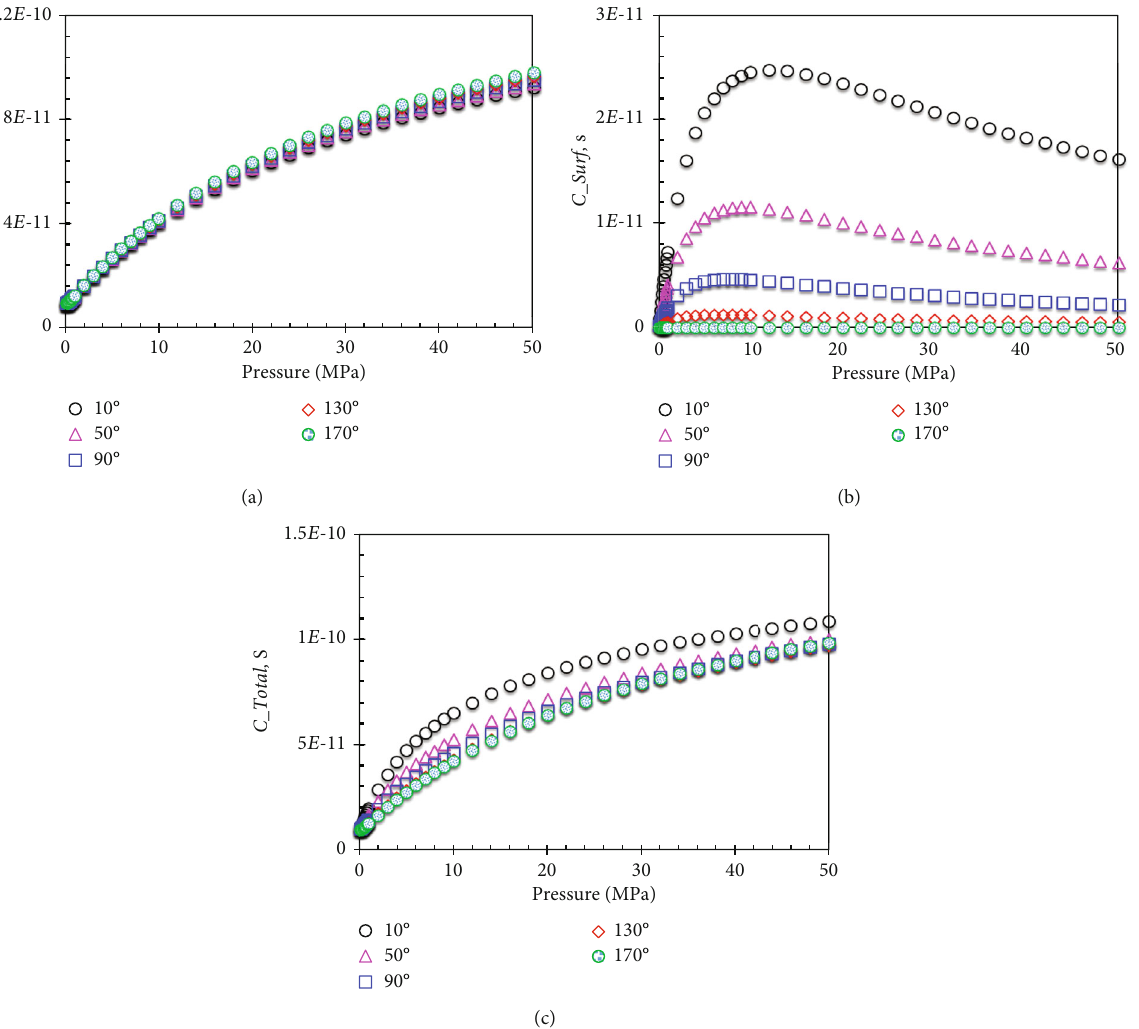
Figure 10: Wettability impact on gas transport through organic nanopore when pore size is equal to 10 nm: (a) Bulk-like gas conductance; (b) Surface di ff usion; (c) Total gas